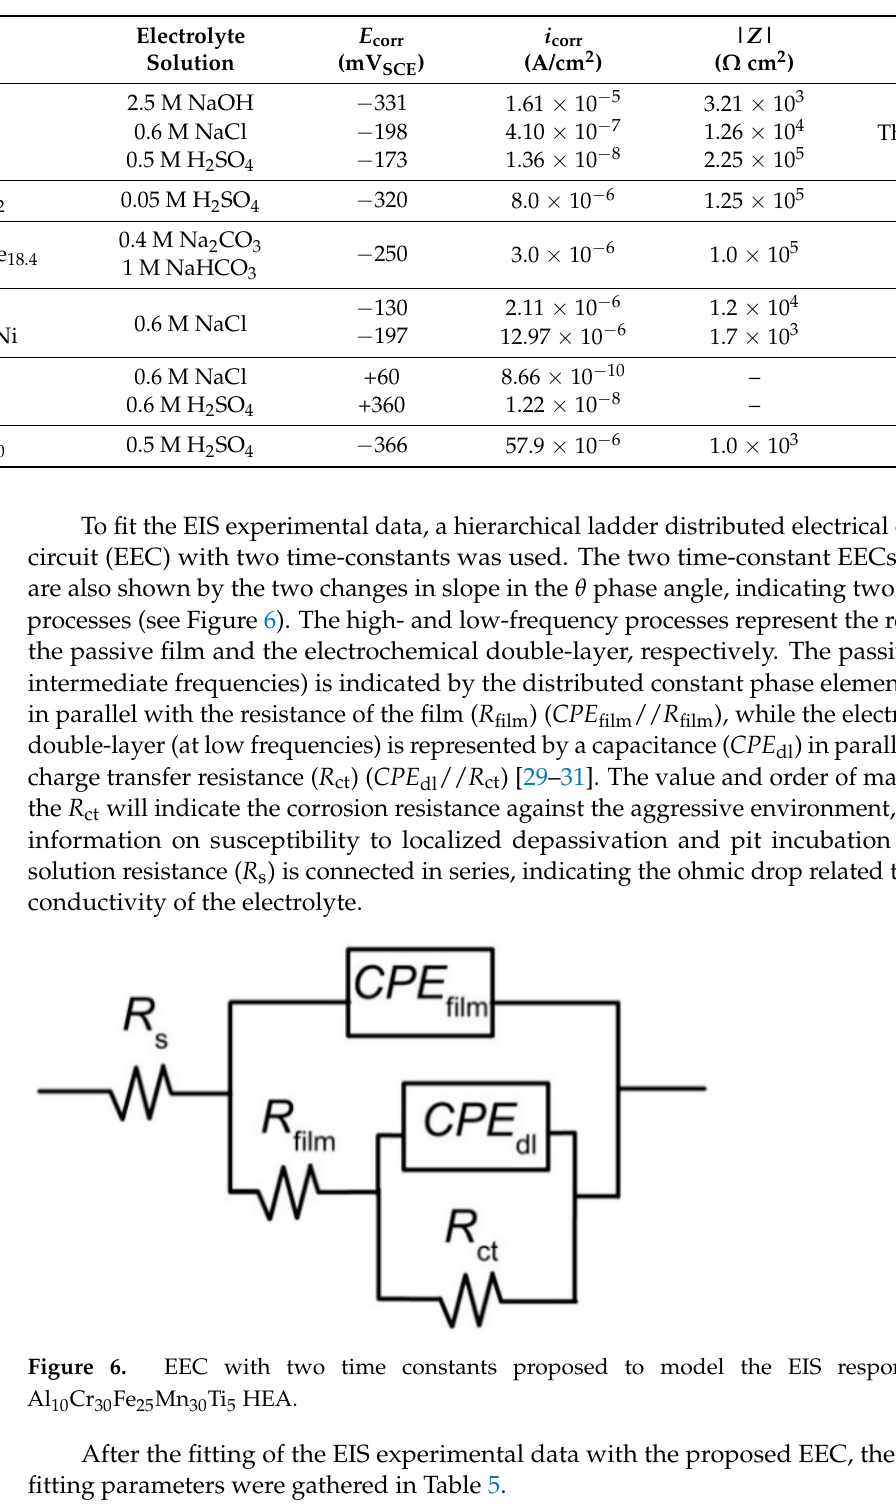
Table 4. Corrosion properties comparison between different HEAs.